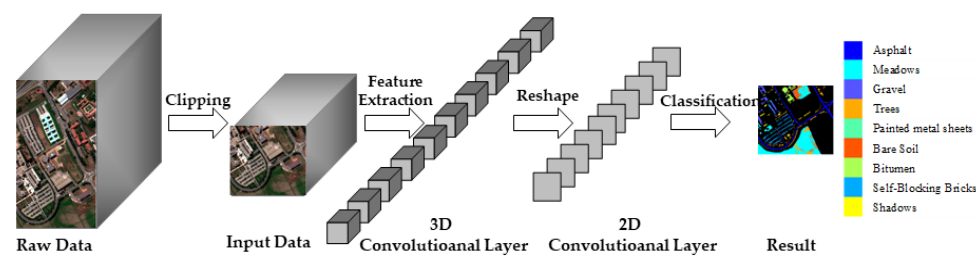
Figure 3. HSI Classification Based on 3D–2DCNN.